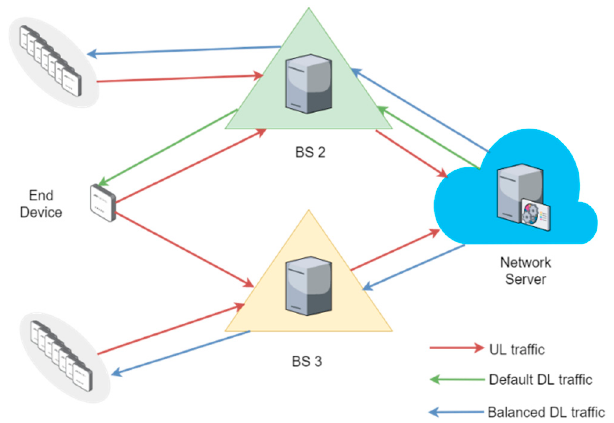
Figure 4. Example of a load-balancing decision to be made.